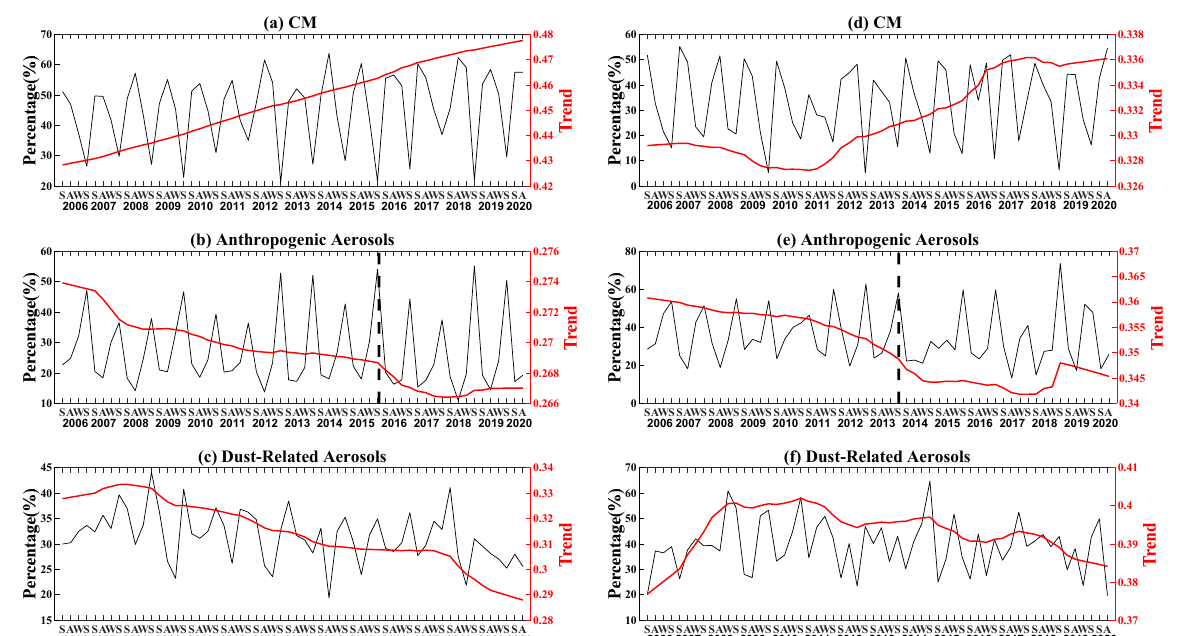
Figure 7. Seasonal variation in percentage (black lines) and BEAST-derived long-term (2006~2020) trend (red lines) of different aerosol types over the NSCS ( a – c ) and the coastal waters of the GBA ( d – f ). The black dotted lines in ( b ) and ( e ) denote the abrupt points of the long-term trend.